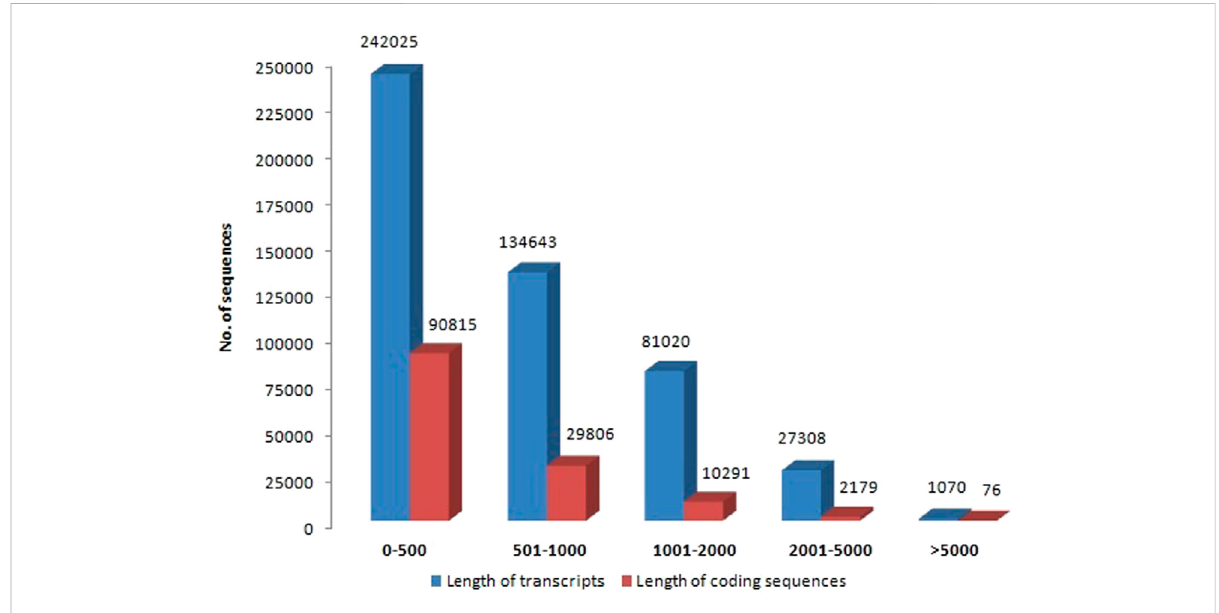
FIGURE 2 Length distribution of allohexaploid Brassica transcripts and coding